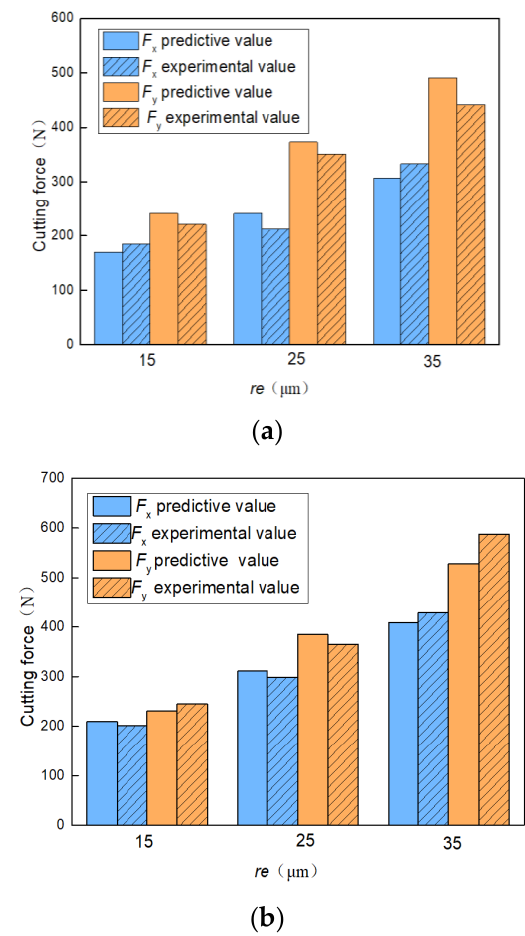
Figure 17. Comparison of cutting force: measured values and model prediction values for fiber cutting angles ( a ) θ = 45° and ( b ) θ = 90°, as a function of the tool edge radius ( r e ).